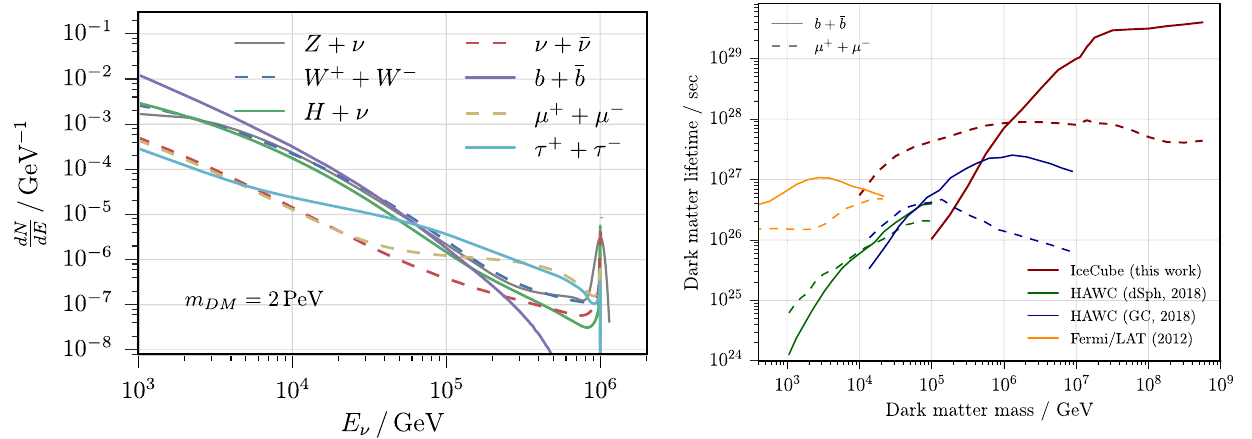
Fig. 32 Left panel: neutrino yield per decay as a function of neu- trino energy (flavour-averaged) for an assumed dark matter mass of 2 PeV. Right panel: IceCube lower limits on dark matter lifetime versus dark matter mass assuming a 100% branching ratio decay to bb (full